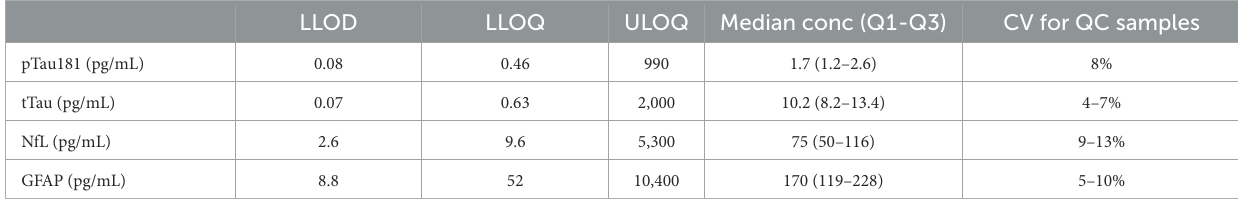
and ONDs ( r = 0.55 and 0.58, respectively; p < 0.001). pTau181 and tTau correlated moderately with GFAP (GFAP/pTau181: r = 0.35, p < 0.001; GFAP/tTau: r = 0.30, p < 0.005) and NfL (NfL/pTau181: r = 0.35, p < 0.001; NFL/tTau: r = 0.54, p < 0.001) within the AD group, but these correlations were lost among ONDs (GFAP/pTau181: r = 0.08; GFAP/tTau: r = 0.10; NfL/pTau181: r = 0.06; NfL/tTau: r = 0.32), likely reflecting that disease mechanisms other than amyloid and tau pathology also increase GFAP and NfL levels in these